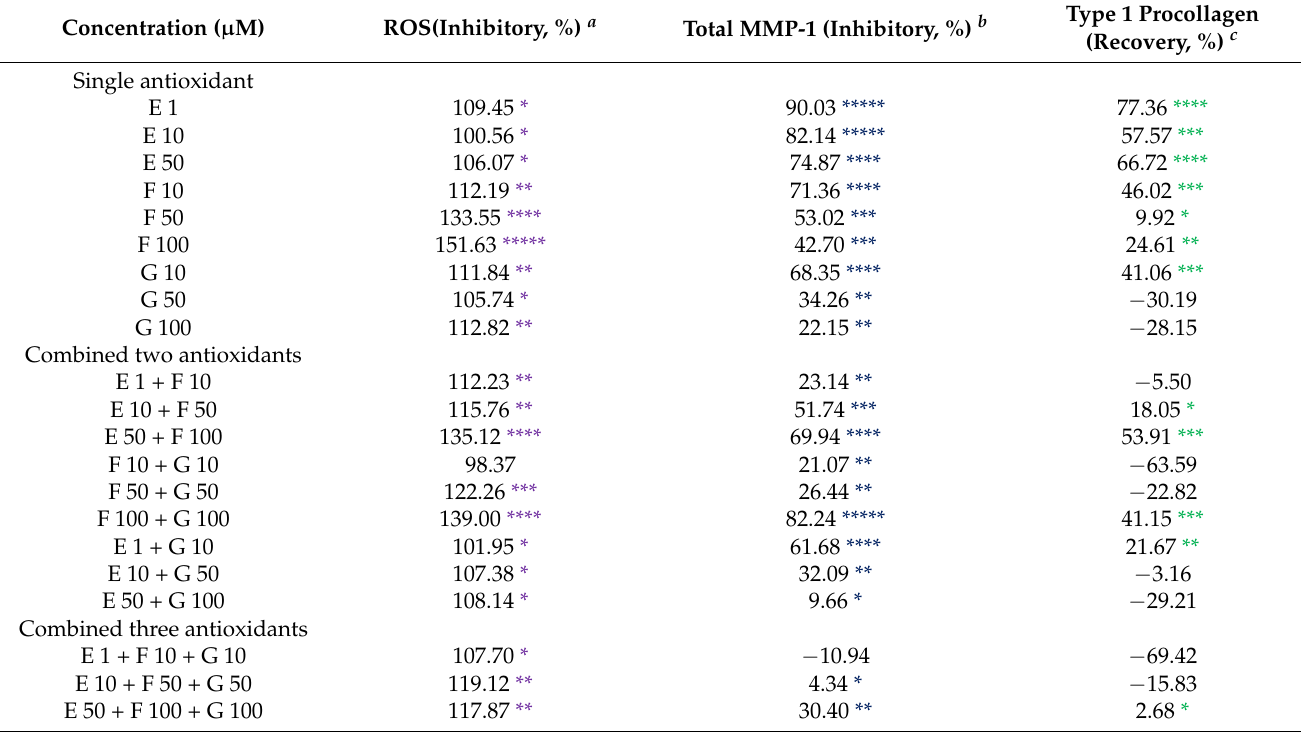
Table 2. The total includes ROS, total MMP-1, and Type 1 procollagen analysis data of three types of antioxidants in the prevention of UVB radiation-induced photoaging in human skin